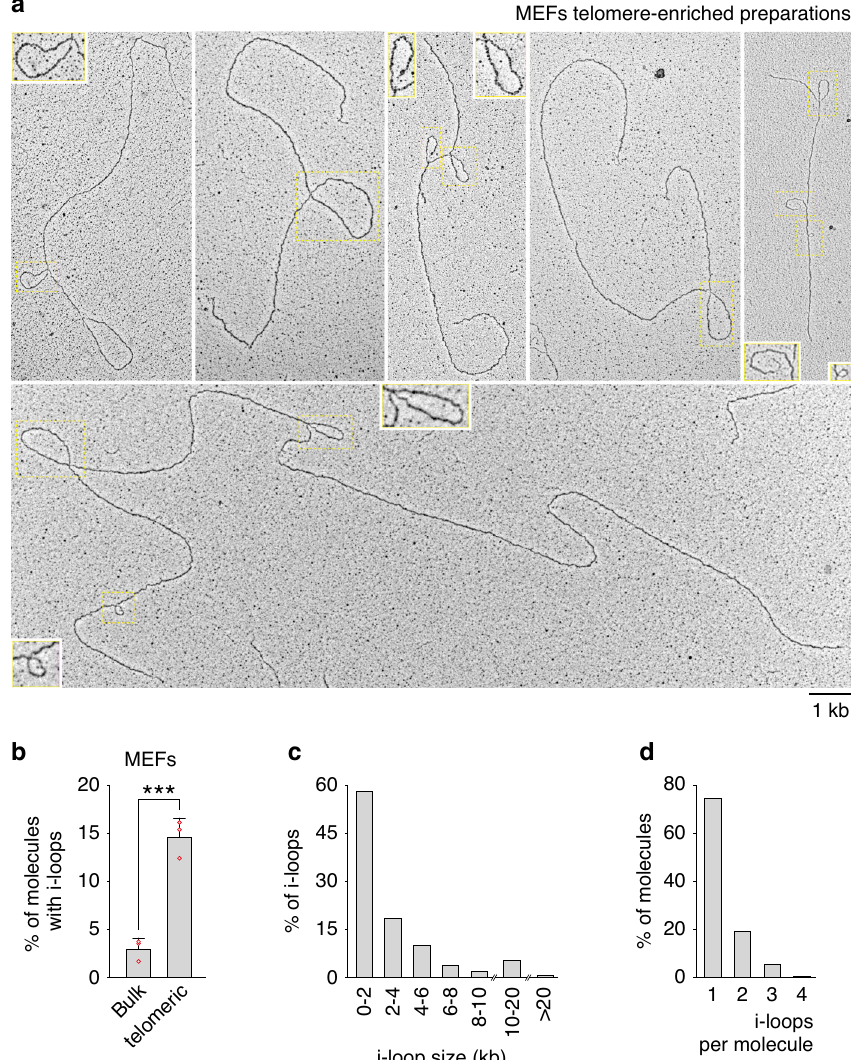
Fig. 2 Frequent i-loops in telomere-enriched samples. a Examples of molecules with i-loops found in the telomeric samples. Telomeric DNA, enriched with the procedure described in Fig. 1, was analyzed in transmission Electron Microscopy (EM). I-loops are indicated by the yellow rectangles. Insets show 2X enlargements of some of the areas inside the yellow rectangles. b Quanti fi cation of i-loop occurrence. Telomere-enriched (telomeric) and non-enriched genomic DNA (bulk) were analyzed in EM as described above. The non-enriched, bulk DNA was digested with KpnI, which generates fragments of 10 kb in average. The fraction of molecules containing one or more i-loops was scored in 3 independent experiments ( n = 310, 715, and 845 molecules for telomere-enriched samples and 1466, 776, and 1776 molecules for non-enriched samples). Bars represent the mean with the standard deviation. Single data points are also shown as red dots. P value = 0.0009, was derived from unpaired, two-tailed, Student ’ s t -test. Source data are provided as a Source Data File. c Size distribution of the i-loops in the telomeric DNA. N = 342 i-loops. Source data are provided as a Source Data File. d Distribution of the number of i-loops per molecule in the telomeric DNA. N = 266 molecules with i-loops. Source data are provided as a Source Data